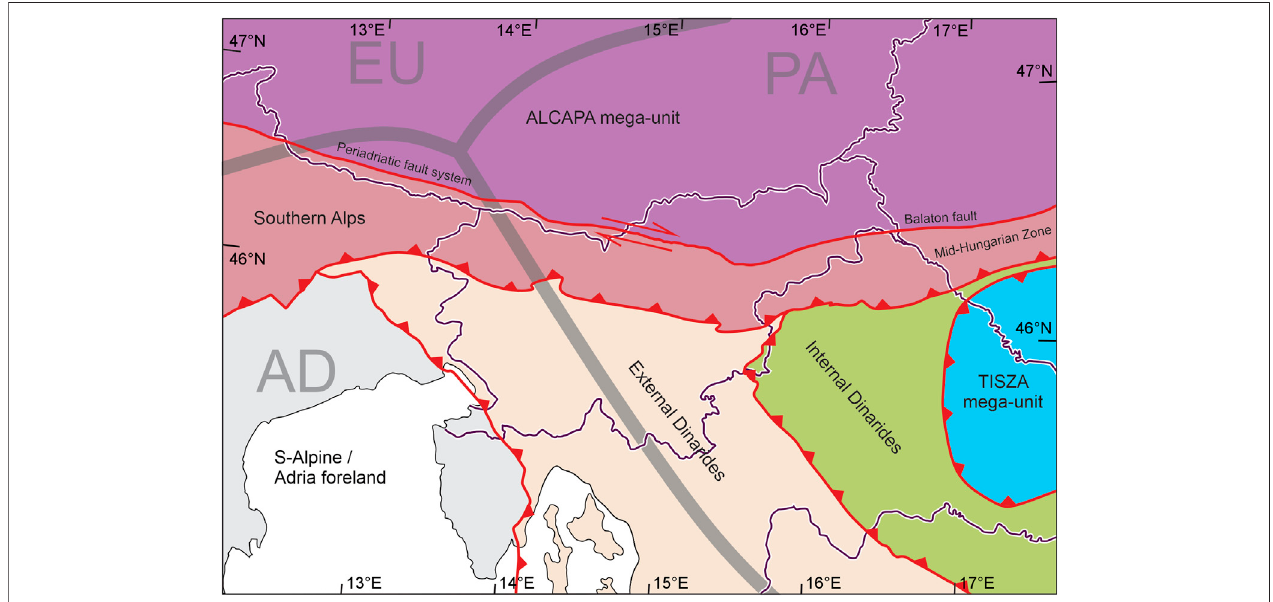
FIGURE2| Generalstructure and regionaltectonicsubdivisionofSlovenia anditsvicinity. Thethickgraylines represent theboundarybetweentheEuropean plate (EU), the Adria microplate (AD) and the Pannonian Domain (PA) (from Brückl et al., 2010). Higher order units are compiled and simpli fi ed from Schmid et al. (2020).